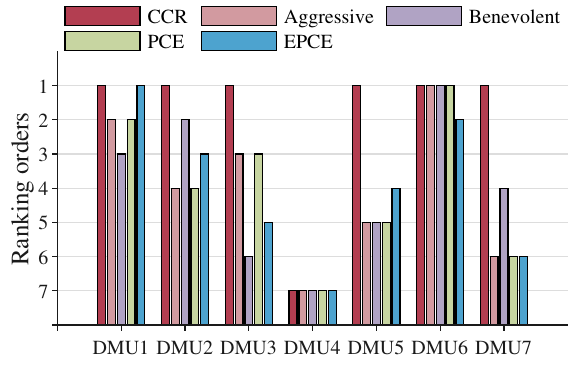
Figure 3. The ranking orders of the